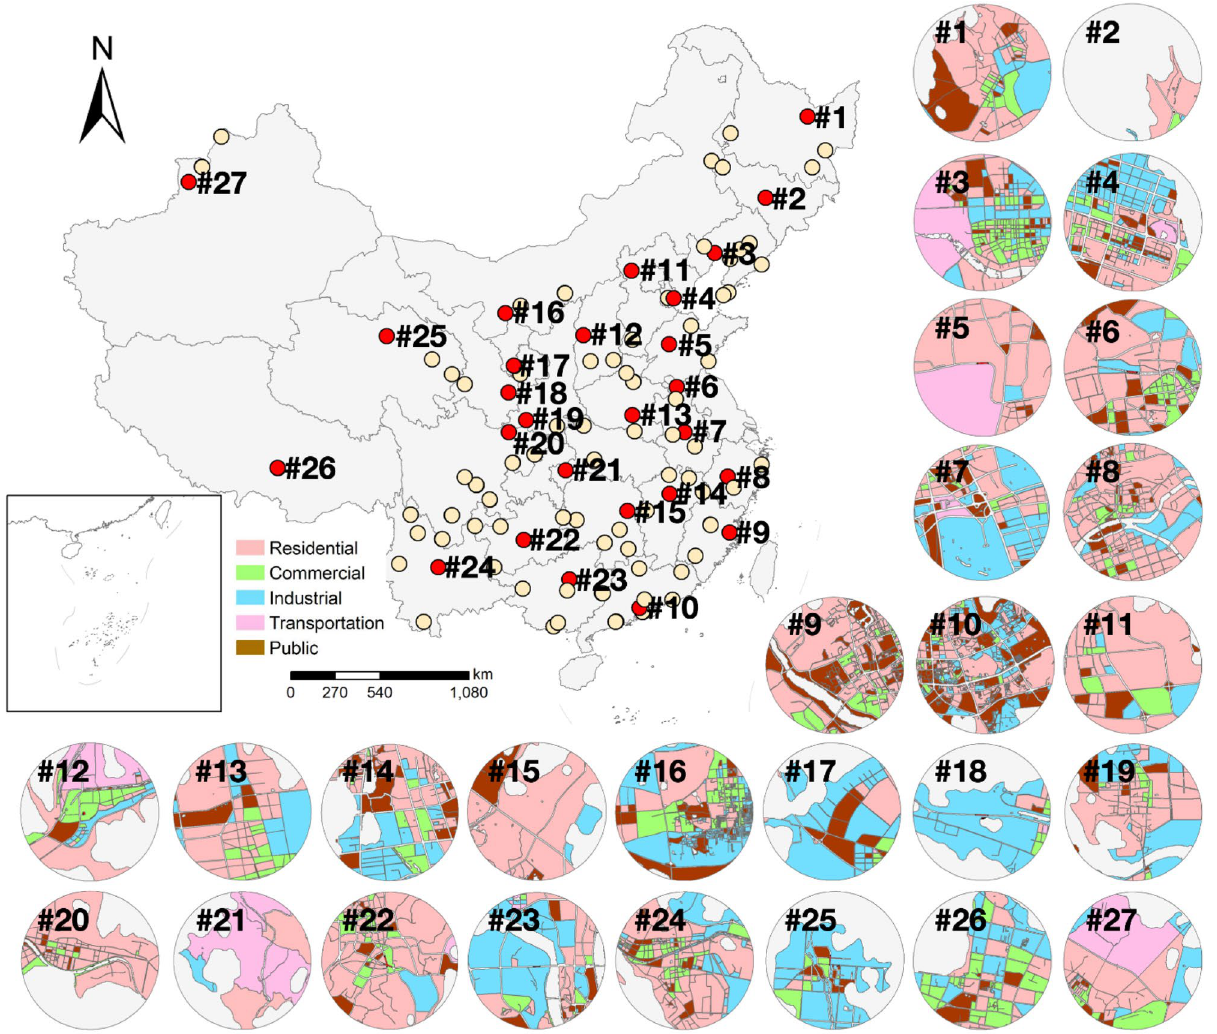
Figure 7. Distribution of urban functions within buffers of selected air stations. 27 sites of 145 air stations with 3 km buffers were displayed. Urban functions including residential, commercial, industrial, transportation and public functions are involved to depict fragmentation characteristics. The maps are performed using ArcGIS Pro software (version 2.7, https:// www. esri. com/ en- us/ arcgis/ produ cts/ arcgis- pro/ overv